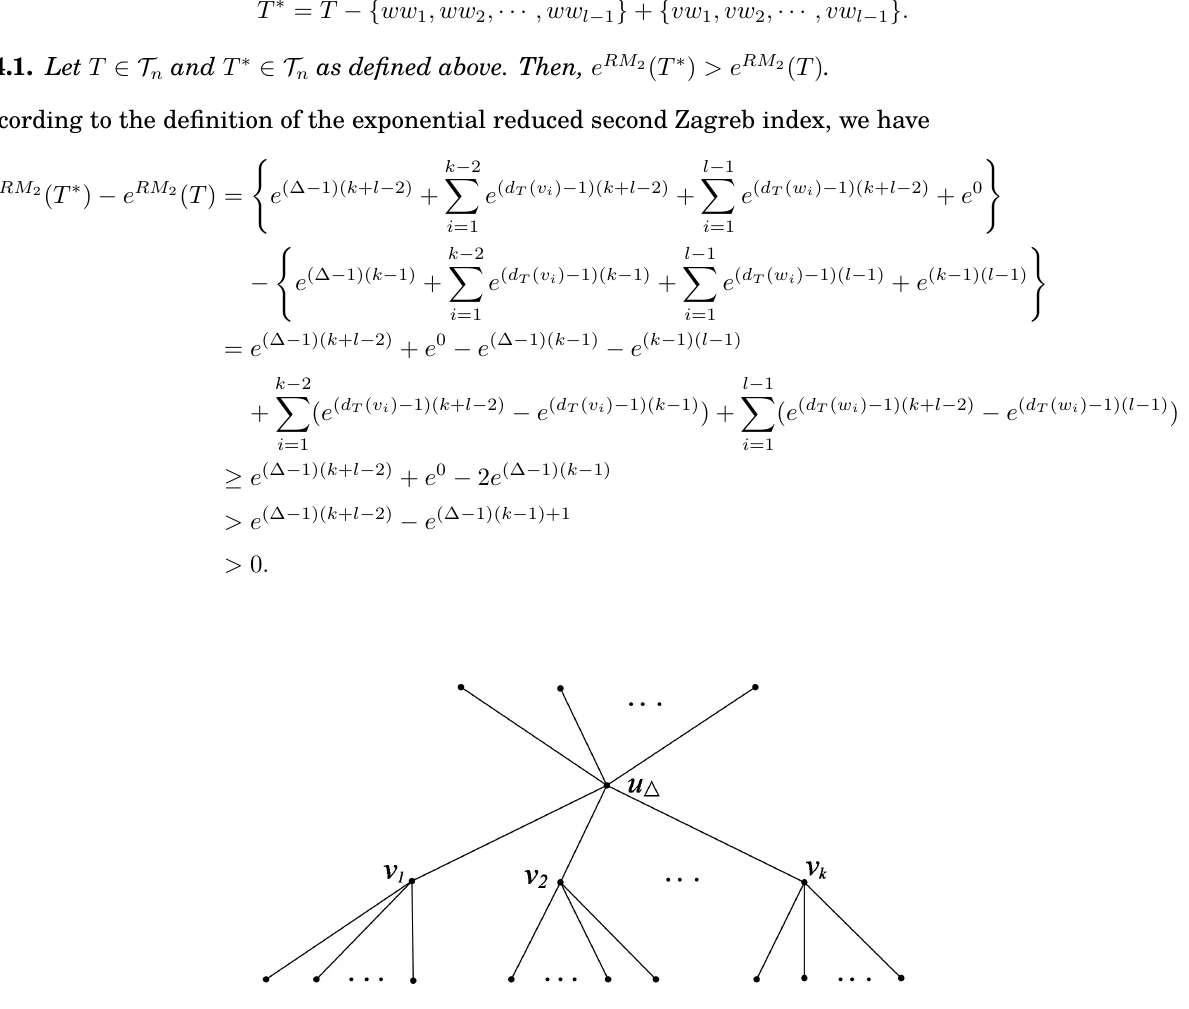
Figure 5: The structure of T ∈ T n with the maximum exponential reduced second Zagreb